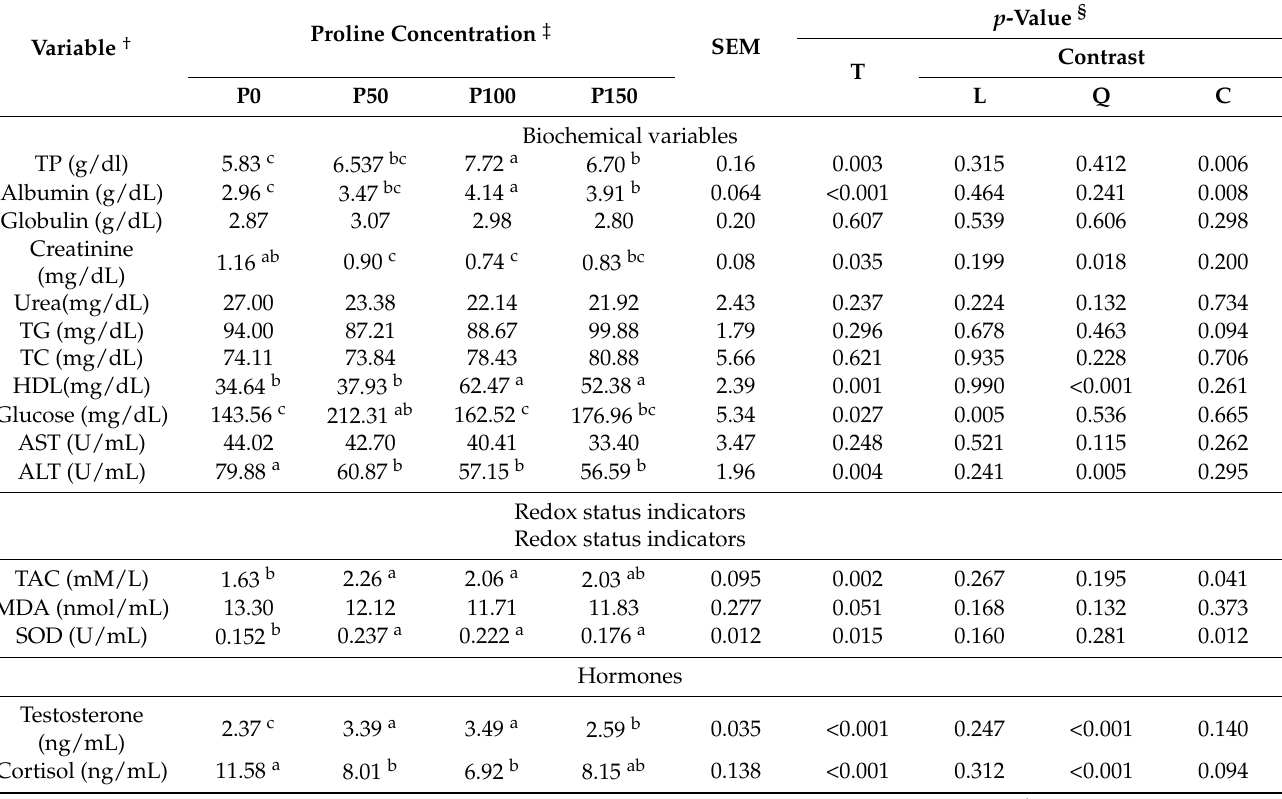
Table 4. Concentration-dependent effects of proline on biochemical variables, redox status indicators, and hormones in rabbit bucks; data are expressed as least square means ± standard errors of the mean